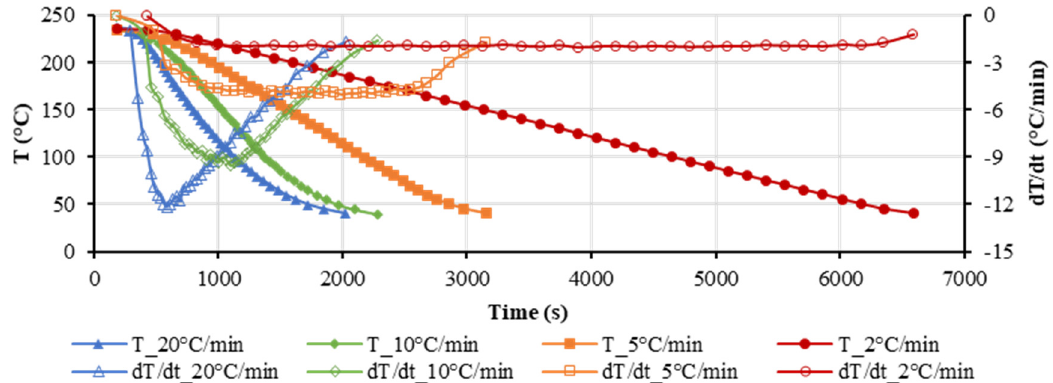
Figure 4. Actual temperature and cooling rate as a function of time during the pvT measurement.